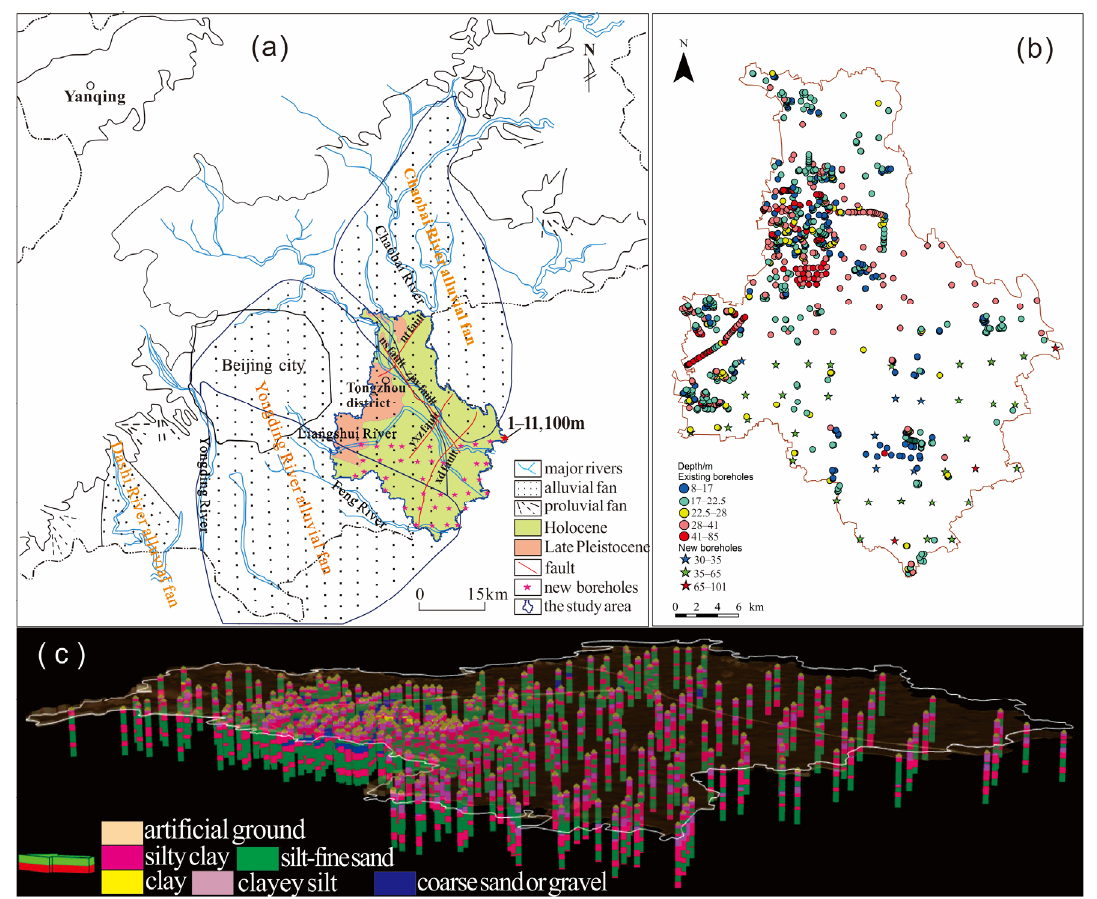
Figure 1. ( a ) Distribution map of alluvial fans in the Beijing plain area (adapted from [41]); ( b )distribution of original and new added boreholes in the study area; ( c ) boreholes selected for modeling in the study area.